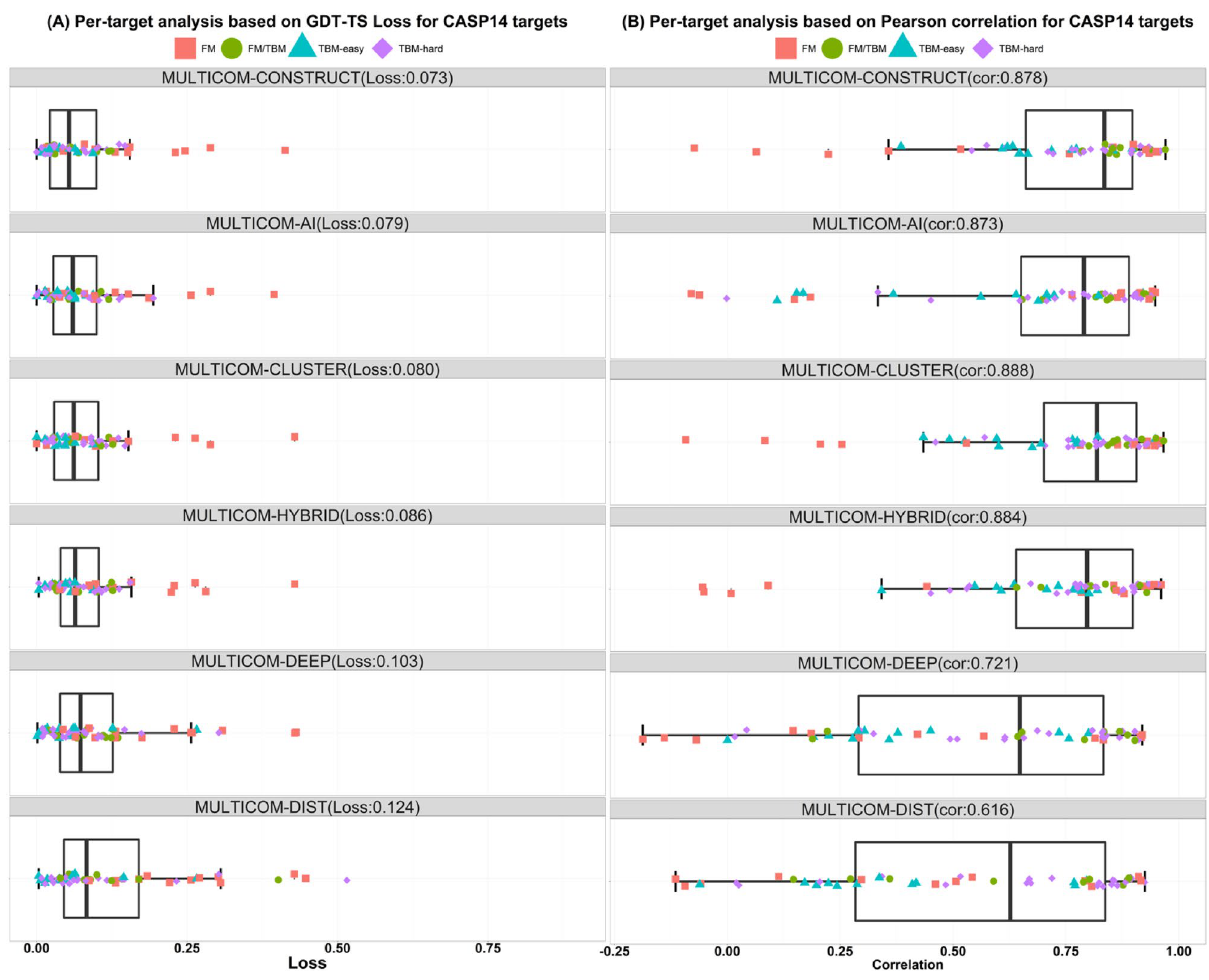
Figure 3. The boxplots of MULTICOM predictors’ performance on CASP14 targets. ( A ) GDT-TS score loss. ( B ) Pearson’s correlation score. Different colors/shapes denote different kinds of